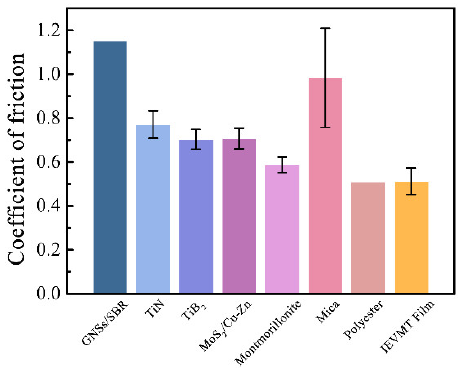
Figure 7. The anti-wear property of IEVMT film compared with other 2D materials.